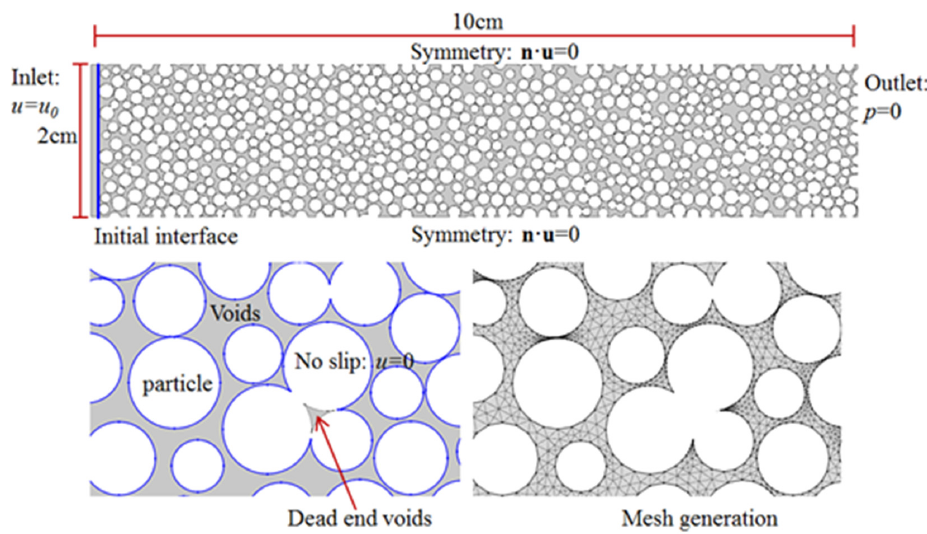
Figure 1. Geometric model and boundary conditions .